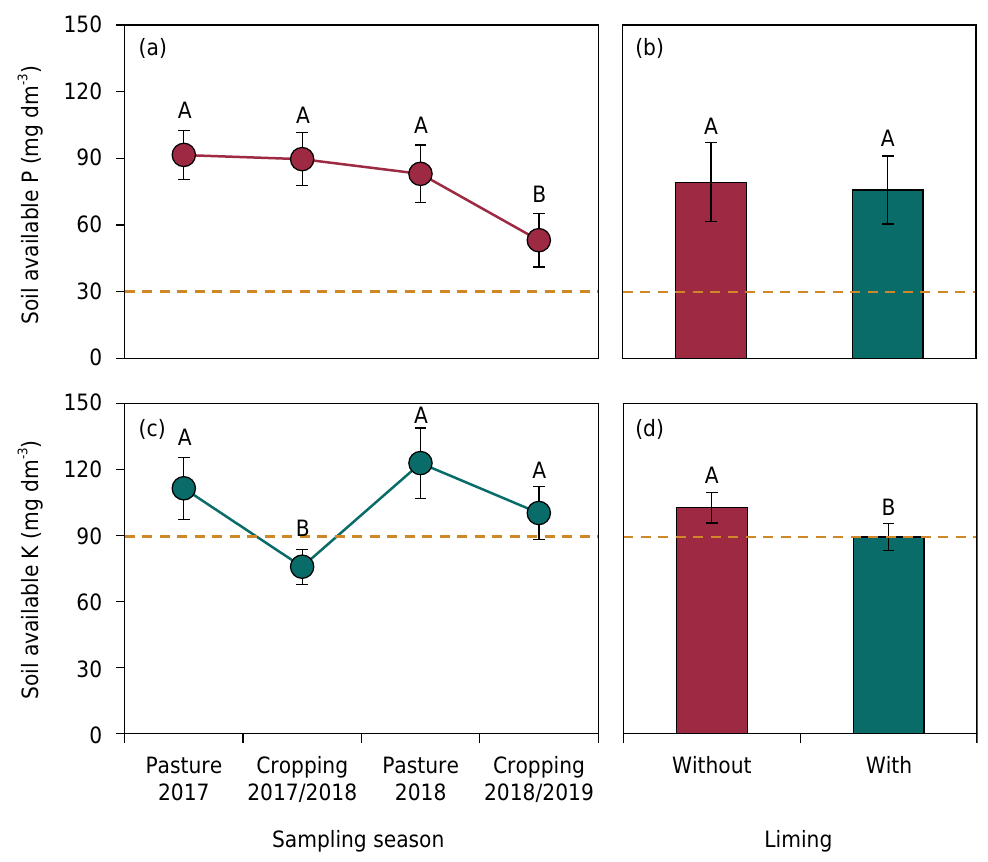
Figure 2. Available phosphorus (P) in the 0.00-0.20 m soil layer as affected by sampling season (a) and liming (b), and available potassium (K) in the soil as affected by sampling season (c) and liming (d) (with or without liming). The orange dotted lines represent the reference values for available P (30 mg dm -3 ) and available K (90 mg dm -3 ) in soil containing ≤200 g dm -3 clay and having a CEC pH7 value of 7.6–15 cmol c dm -3 (CQFS-RS/SC, 2016). Different letters denote significant differences as per Tukey’s test